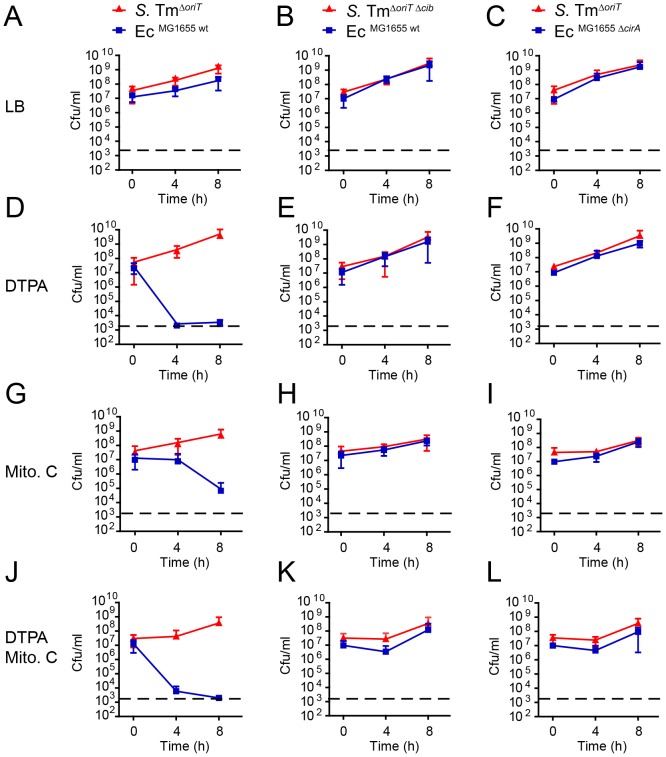
ColIb dependent competition of S. Tm and E. coli in vitro.Overnight cultures of S. TmΔoriT and EcMG1655 (A, D, G, J), S. TmΔoriT Δcib and EcMG1655 (B, E, H, K) or S. TmΔoriT and EcMG1655 ΔcirA (C, F, I, L) were diluted and normalized to an OD600 of 0.05 for each strain in fresh LB with indicated supplements (0.25 µg/ml mitomycin C (Mito. C); 100 mM DTPA). Cfu/ml of both strains were determined at 0 h, 4 h, and 8 h after the start of the subculture. Red lines: S. Tm strains, blue lines: E. coli strains. Dotted line: detection limit (2000 cfu/ml).